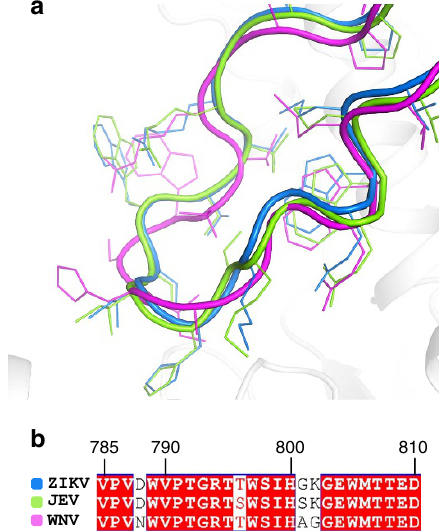
Figure 5 | Tertiary structural comparison of flaviviral priming loops. ( a ) Superposition of ZIKV (blue), JEV (green) and WNV (magenta) priming loops. ( b ) Alignment of the NS5 RdRp sequences of ZIKV, JEV and WNV priming loops. Red boxes show conserved